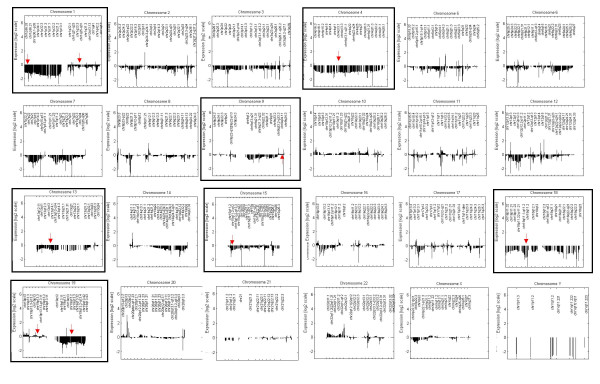
Main pattern of chromosomal expression extracted by CHROMOWAVE. This pattern corresponds to the main eigenvalue extracted by CHROMOWAVE for the tumour data-set. X axis represents the genomic distance along each of the 24 chromosomes and the Y axis represents the gene expression contribution (intensity and direction, log2 scale). Chromosomes on which similar levels of gene expression are seen along the entire chromosome (chromosomes 4, 18, 13, 15) or a chromosome arm (chromosomes 1p, 19q) are shown in a dark frame. Red arrows point to the location of the FISH probes used for structural analysis.